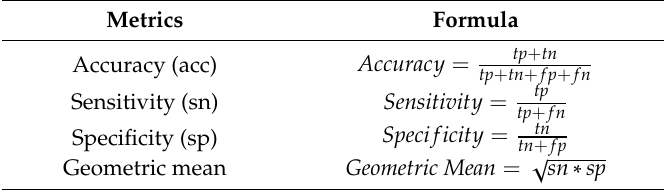
Table 3. Performance metrics for model comparison (for the abbreviations, please see Table 1 or Table